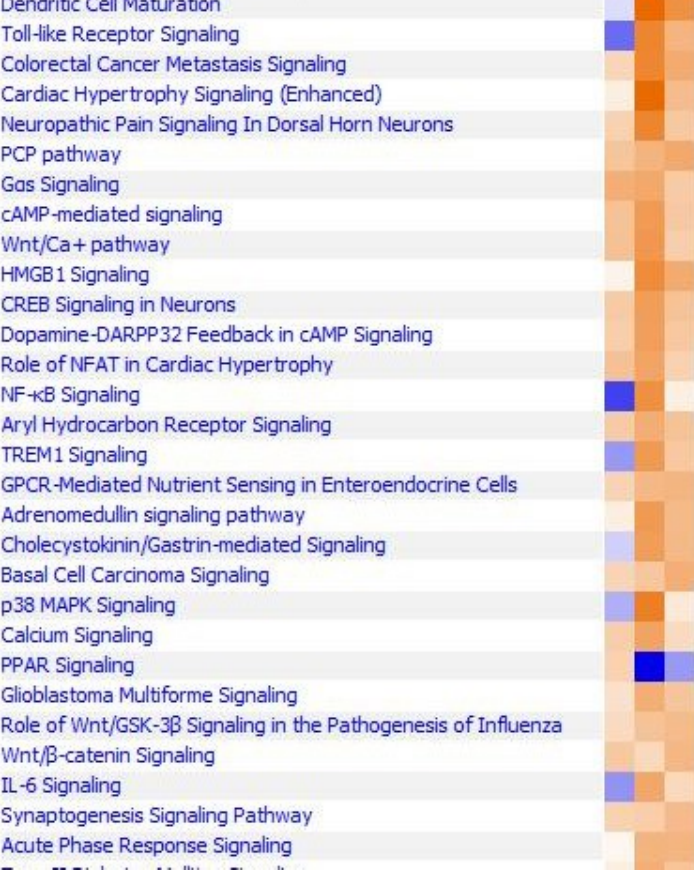
Figure 3. The mediators involved in signaling pathways that were downregulated by RES. The role of RES (DR), LPS (DL), and LPS + RES (DLR) on gene expression of mediators involved in the agonist-induced signal transduction in treated PBMC from PwD2 are described in the legend to Figure 2. RNAseq data were first extracted using the DEG analysis and analyzed by ingenuity pathways analysis. Z scores were plotted against the signaling pathways, where dark orange denotes maximum activation and dark blue maximum repression.